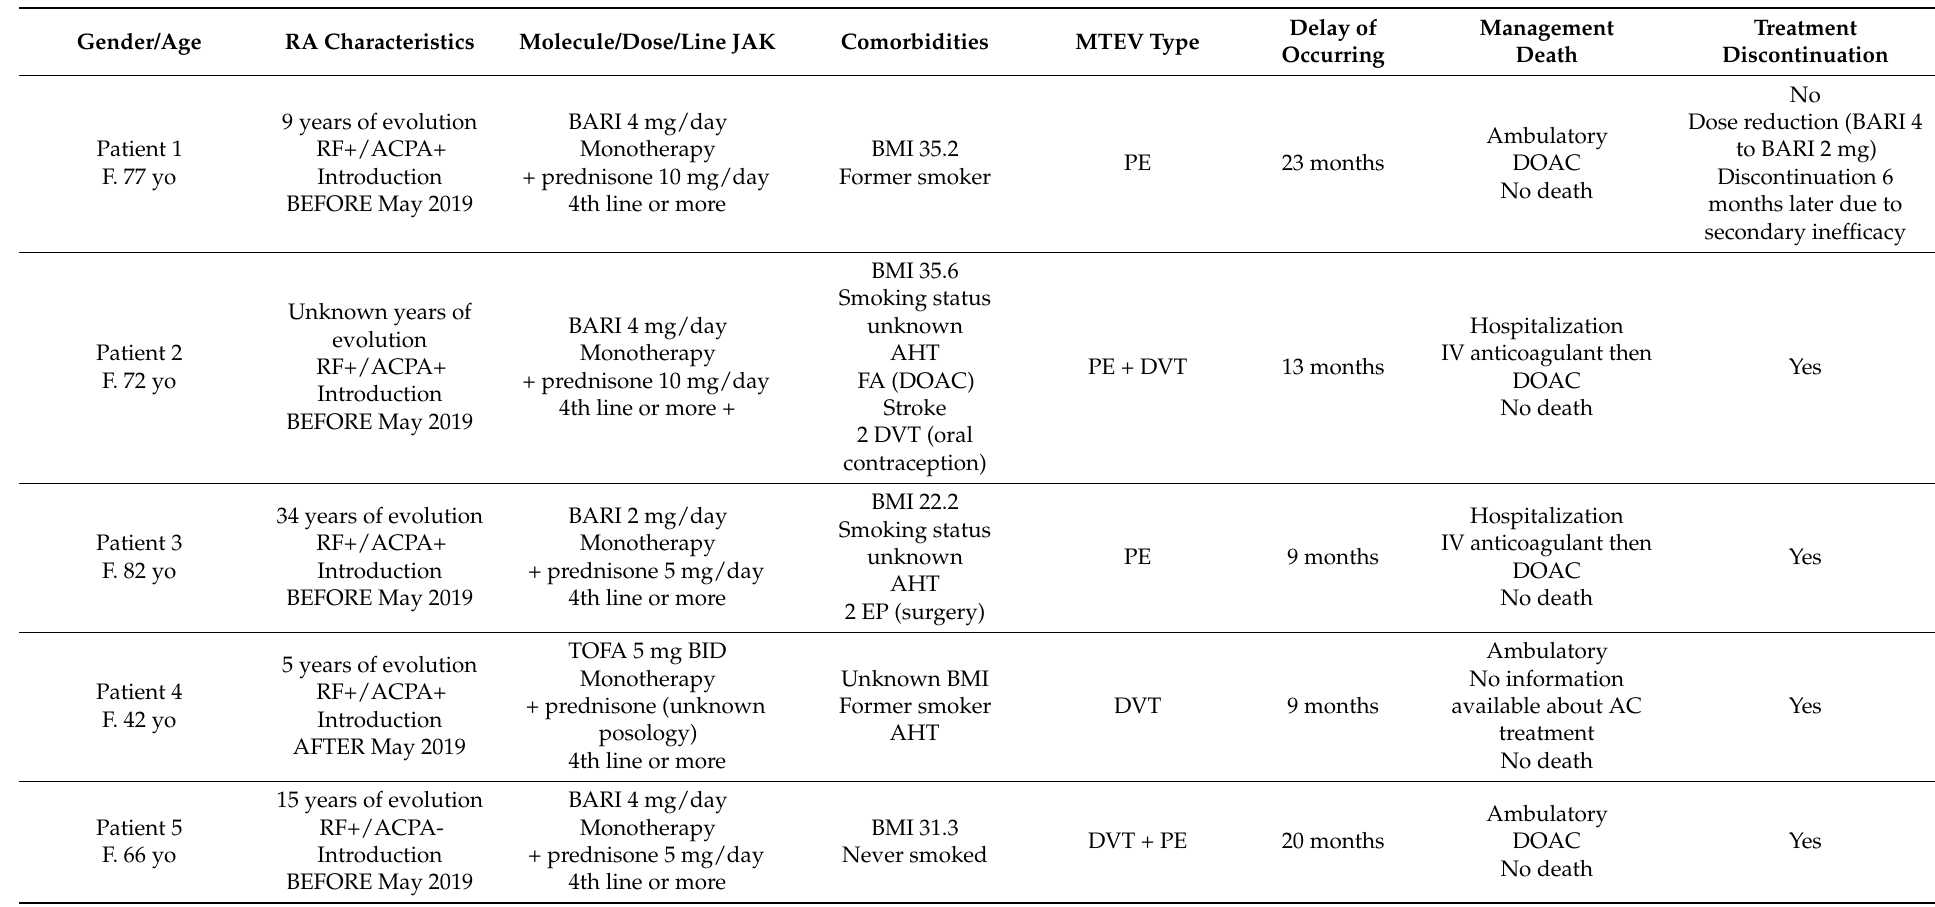
Table 4. Venous thromboembolic complications in our